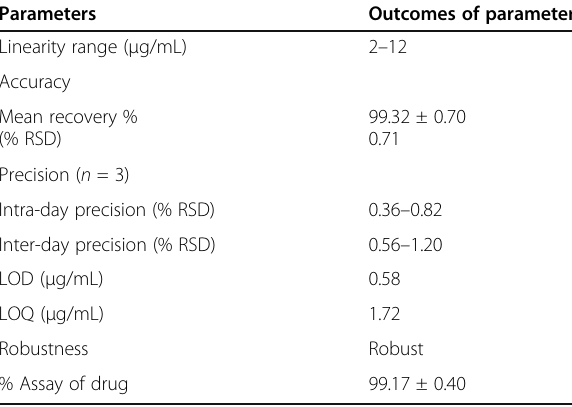
Table 3 Summary of validation